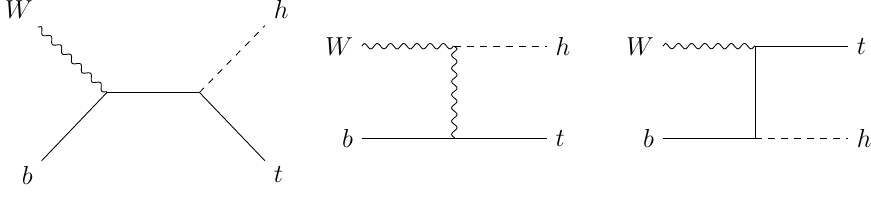
Figure 1 . Tree-level diagrams contributing to Wb ! th